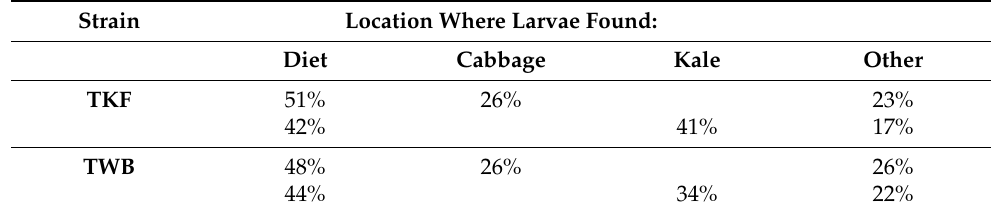
Table 2. Percentage of first instar Helicoverpa armigera larvae from selected TKF and the parental TWB strain found on artificial diet, cabbage or kale, and other (agar or Petri dish lid) after 48 h. Strain Location Where Larvae Found: Diet Cabbage Kale Other TKF 51% 26%